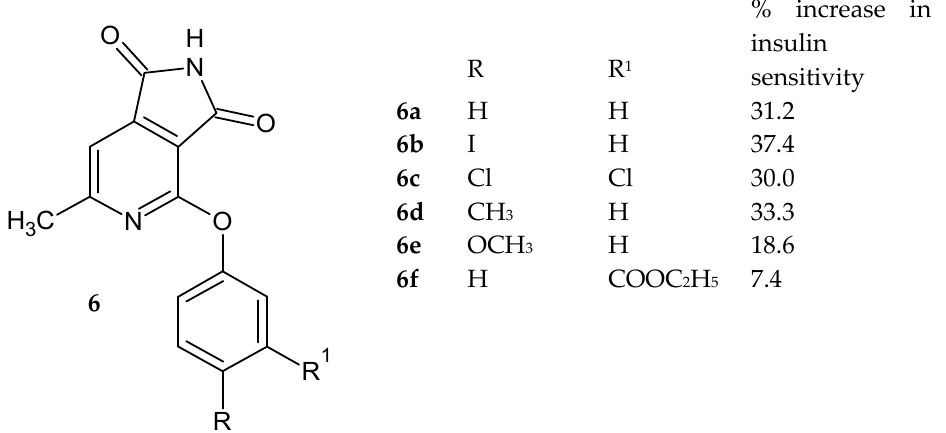
Figure 3. 6 ‐ Methyl ‐ pyrrolo[3,4 ‐ c ]pyridine ‐ 1,3( 2H ) ‐ dione derivatives 6a – f increased the insulin